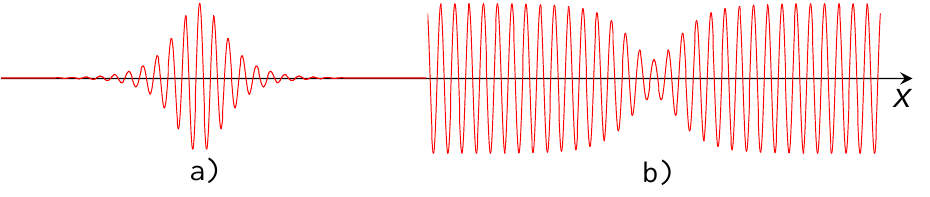
Figure 11. (Color online) Examples of ( a ) bright and ( b ) dark envelope